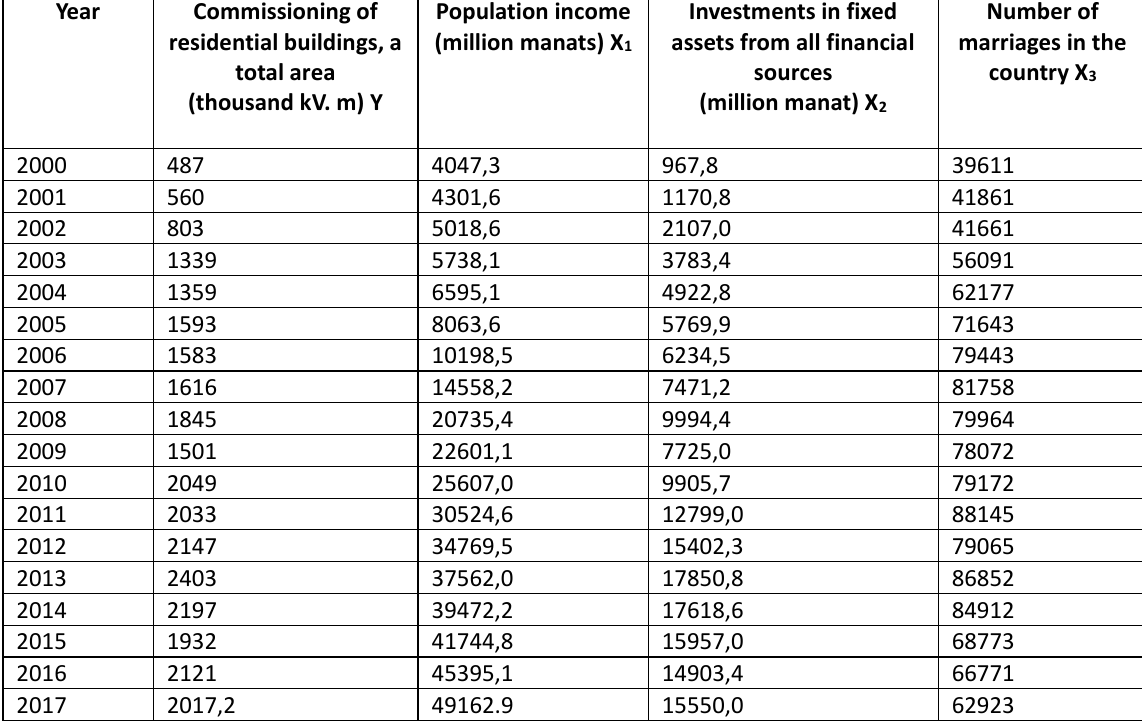
Table 1 Statistical information on the construction sector of the